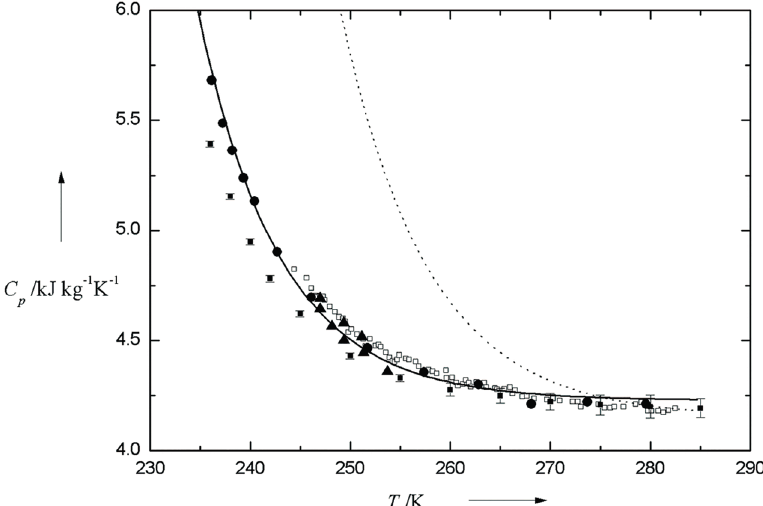
Figure 1. Variation of C p with temperature. Specifically, solid triangle, solid circle, solid square with error bar, hollow square are denoted as the value of C p determined by Bertolini et al. [28], Angell et al. [20,21], Archer and Carter [29], and Tombari et al. [30], respectively. For better comparison, the solid line and dashed line, representing the simulation results from IAPWS-95 and IAPWS-84, respectively [31], are also shown.